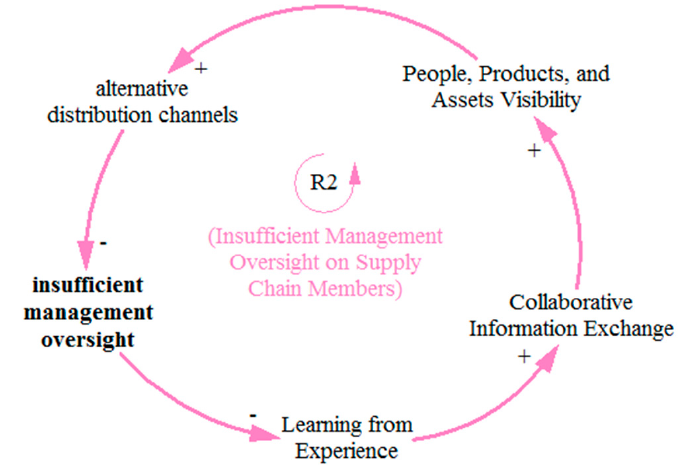
Figure 7. Reinforcing loop R2 (insufficient management oversight on supply chain members).